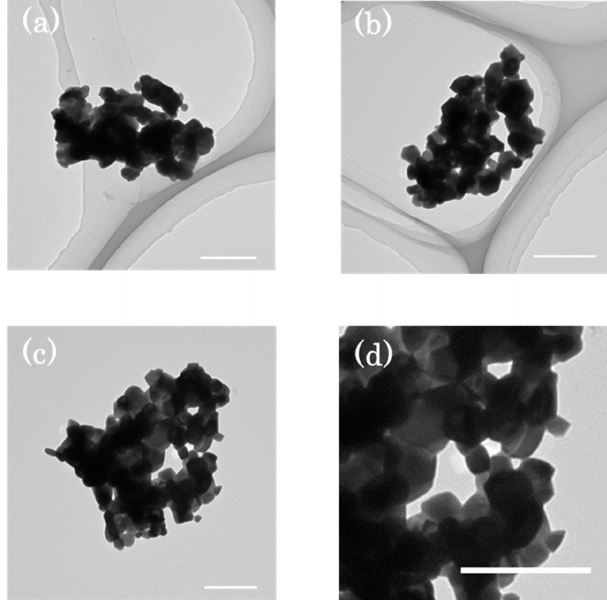
Figure 1. ( a – c ) TEM images of Gd 2 O 3 powder from the sol ‐ gel method: Gd 2 O 3 co ‐ doped ( a ) Tm